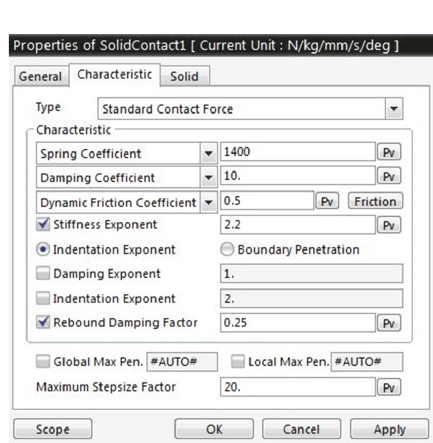
Figure 3: Contact parameters setting.